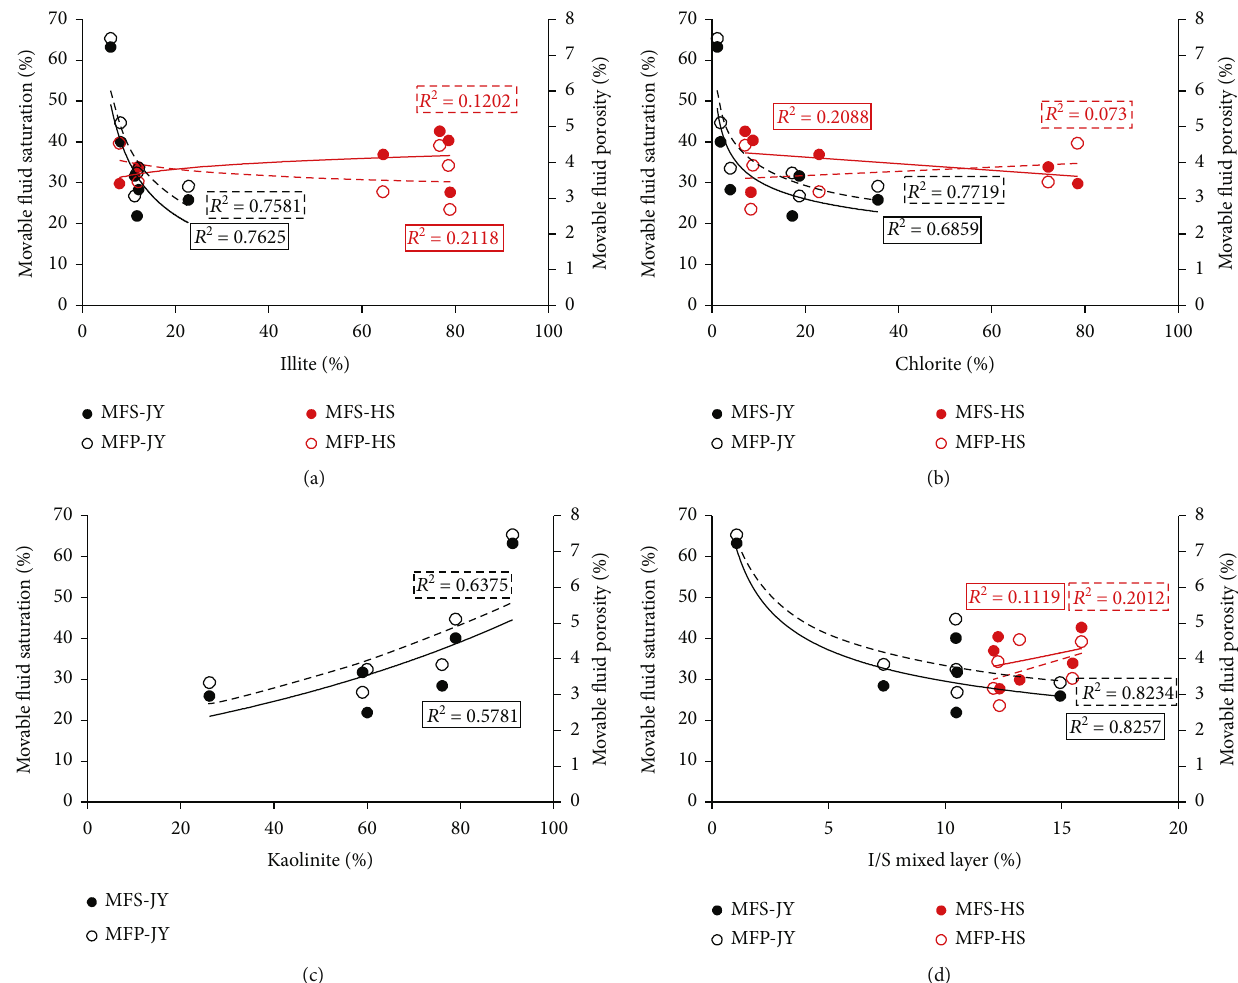
Figure 10: Relationship between clay mineral content and movable fl uid parameters. MFS-JY: movable fl uid saturation in Jiyuan; MFP-JY: movable fl uid porosity in Jiyuan; MFS-HS: movable fl uid saturation in Heshui; MFP-HS: movable fl uid porosity in